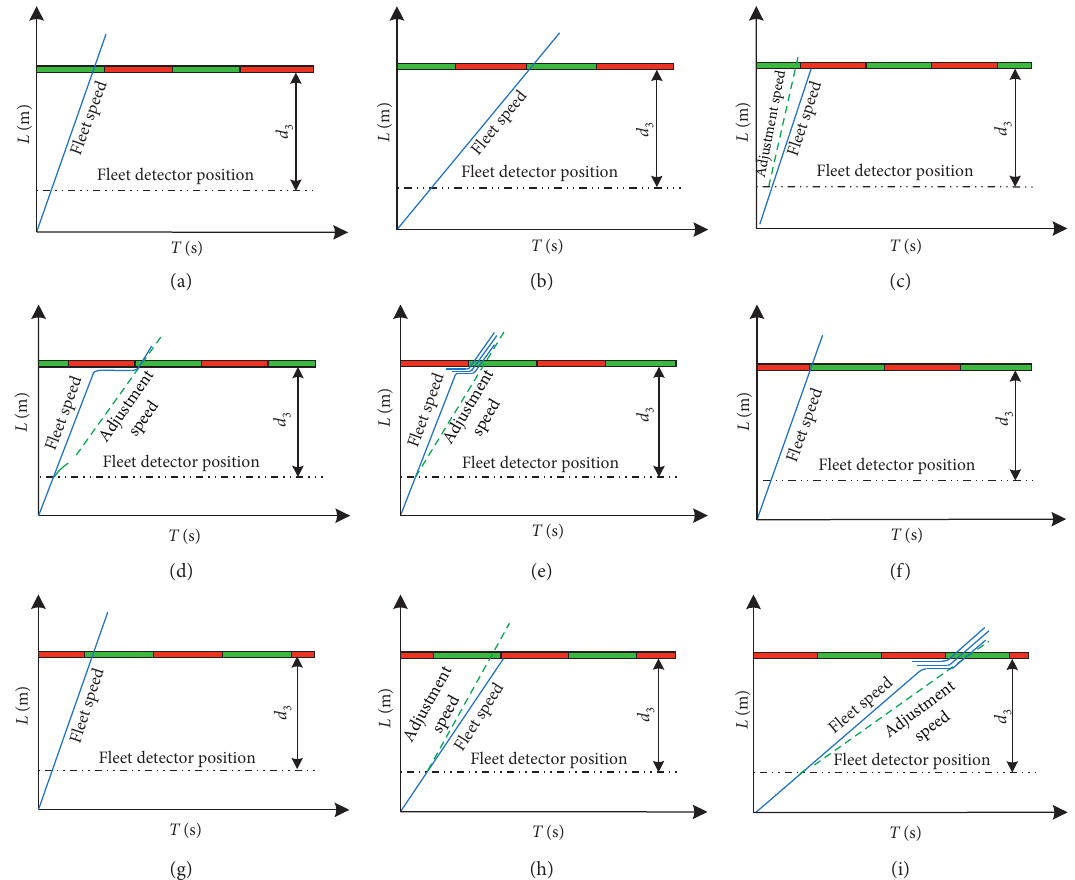
Figure 3: Speed induction of fleet. (a) State 1. (b) State 2. (c) State 3. (d) State 4. (e) State 5. (f) State 6. (g) State 7. (h) State 8. (i) State